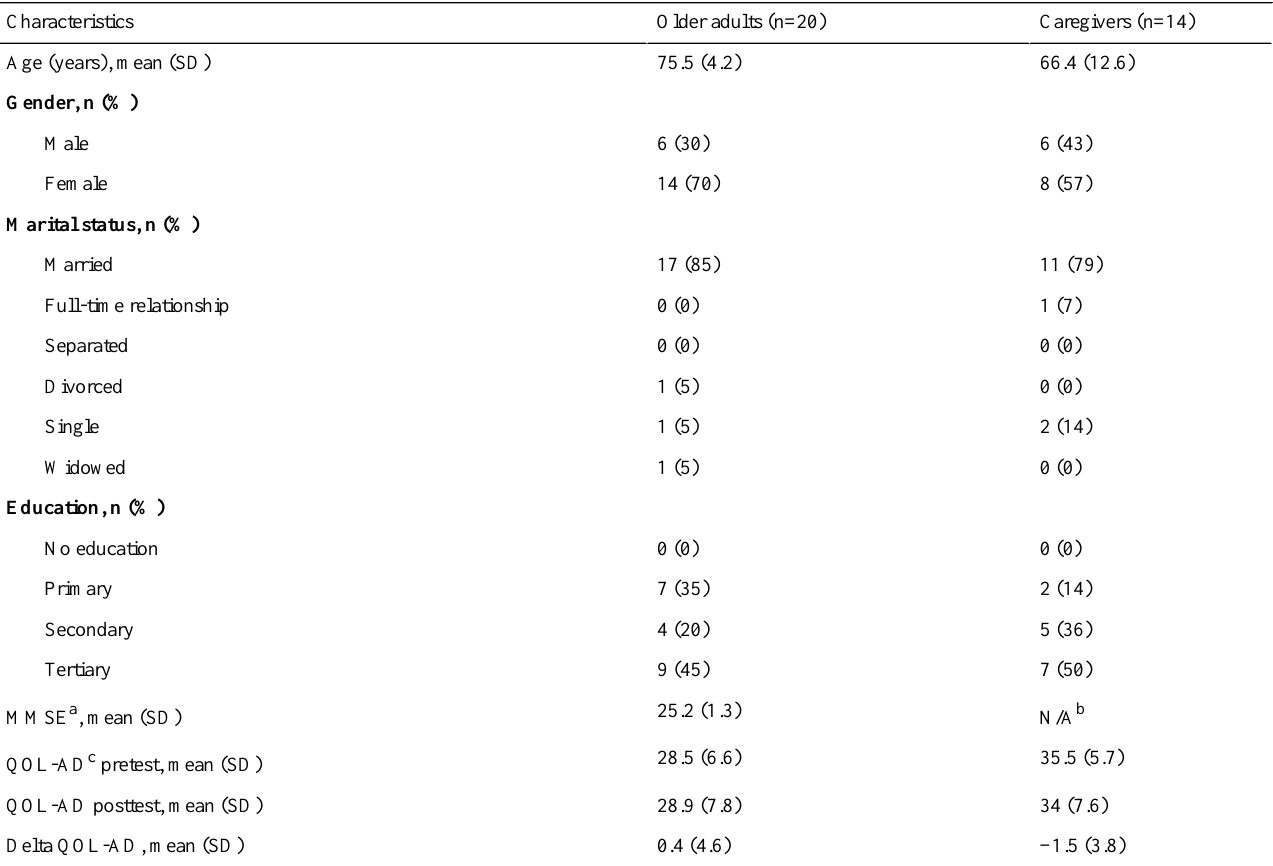
Table 1. Older adults and caregivers characteristics.